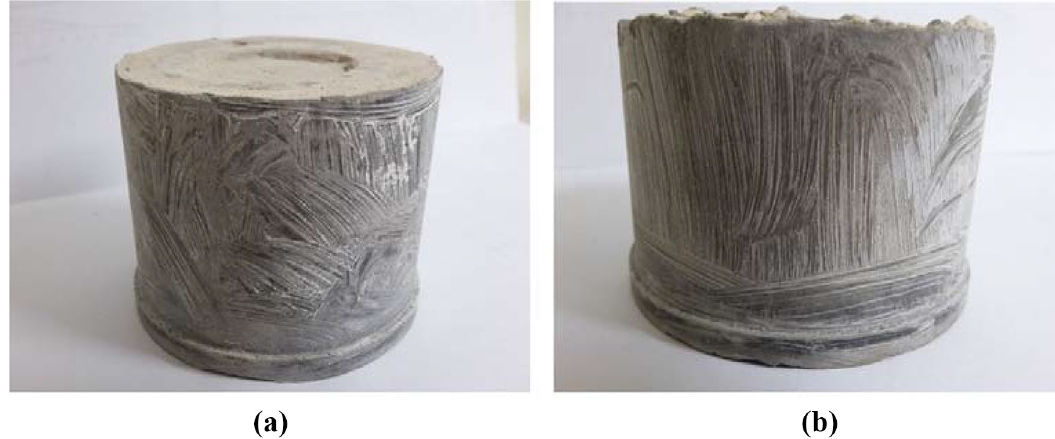
Fig. 7 ( a ) Image of the cement slurry morphology and ( b ) cement slurry mixed with flushing fluid